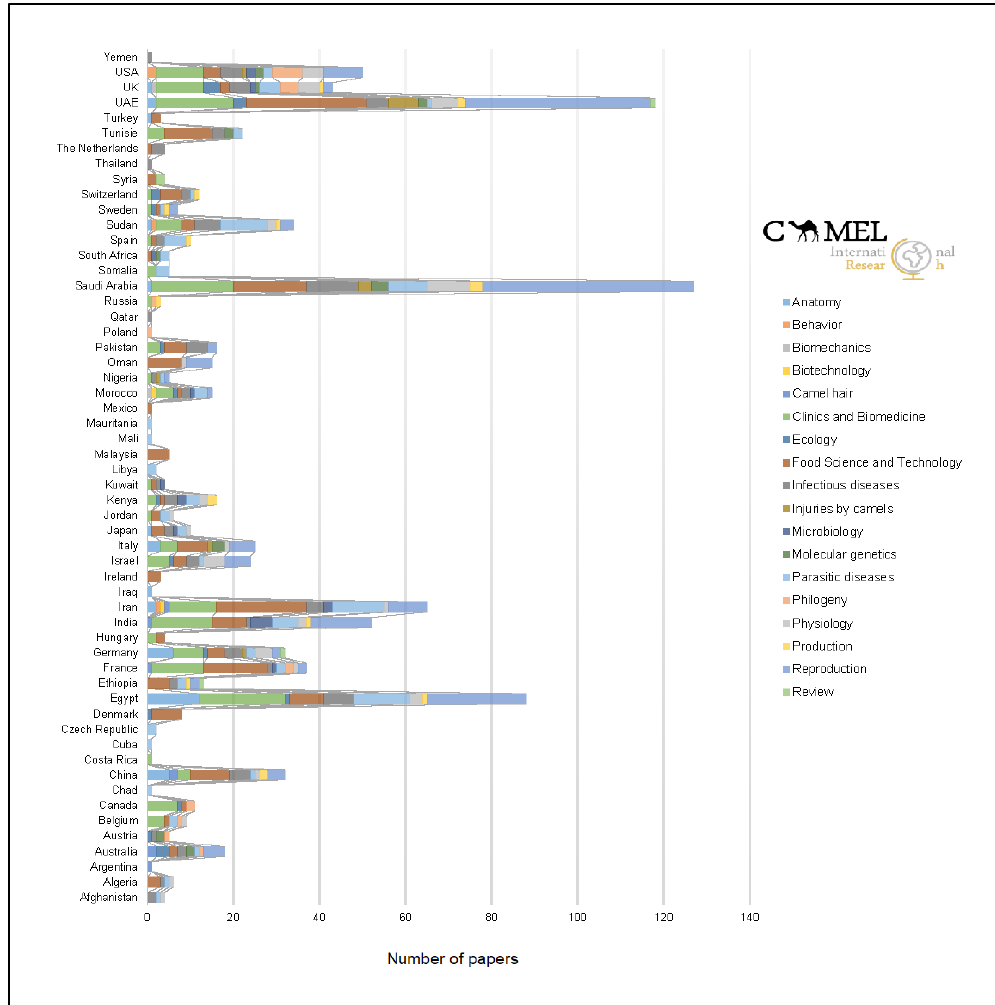
Figure 4. Quantum Geographical Information System (QGIS) map displaying the number of camel research papers per country.